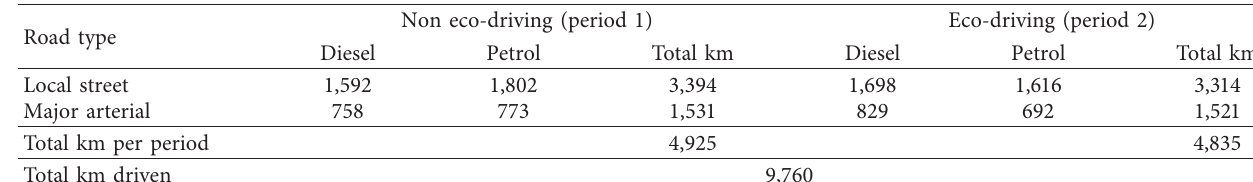
Table 5: Km driven per vehicle, road type, and test period.